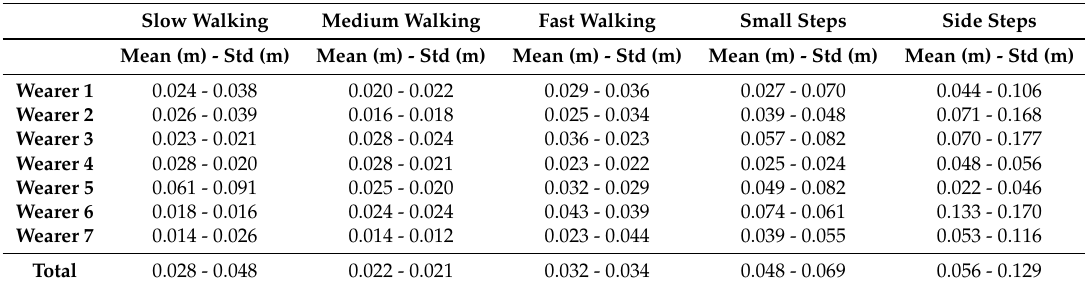
Table 4. Absolute computed stride length error.